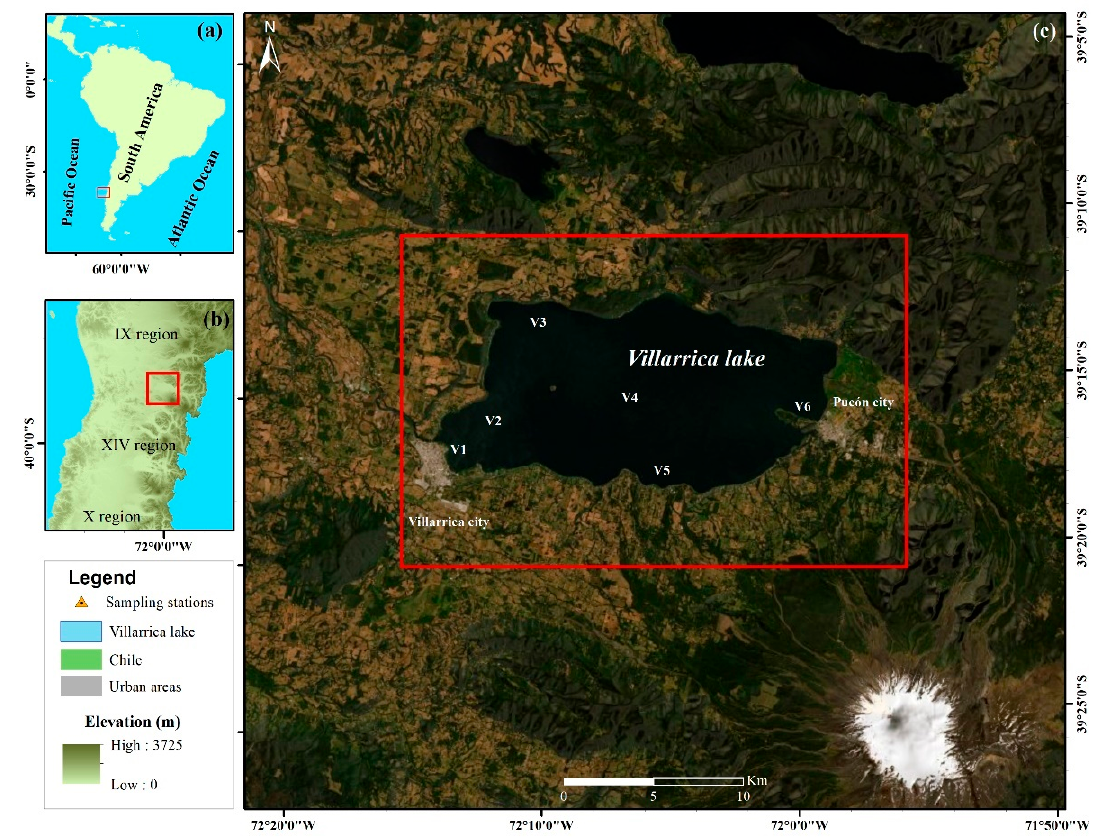
Figure 1. ( a ) Chile in South America, ( b ) location of Lake Villarrica in the 9th Region, and ( c ) satellite image of Lake Villarrica with sampling stations V1–V6, represented by yellow triangles. The grey areas represent the cities on the lake shore. Satellite image extracted from Landsat 8.